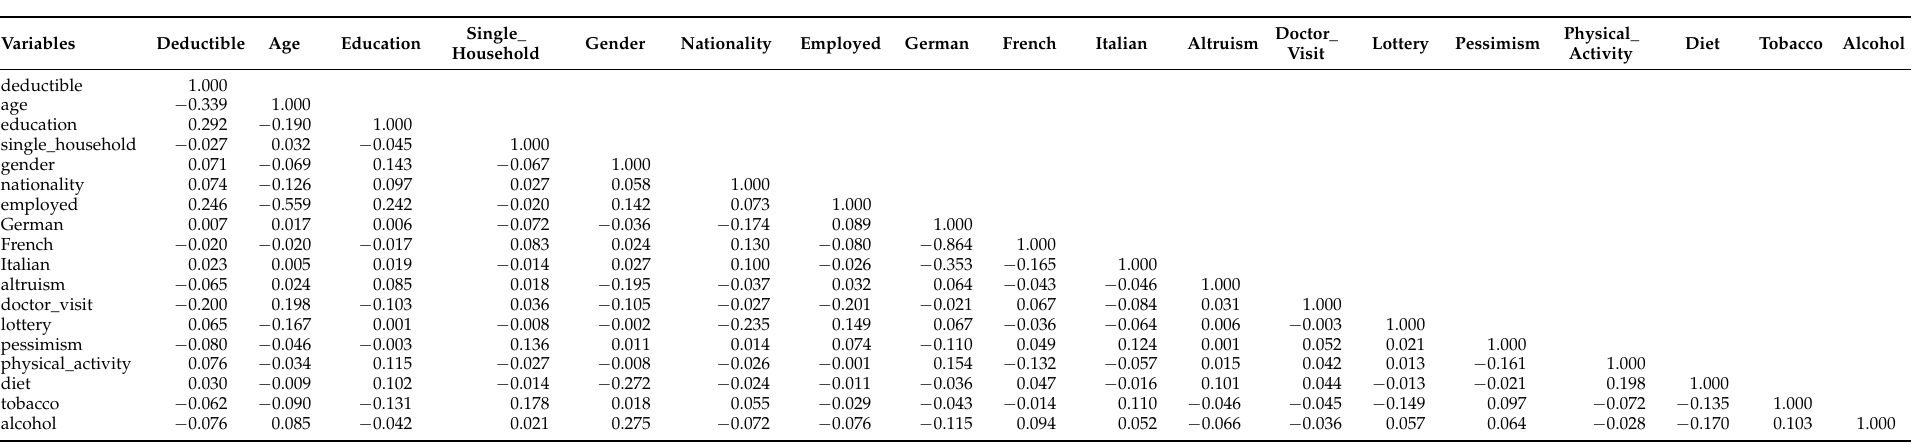
Table 3. Correlation